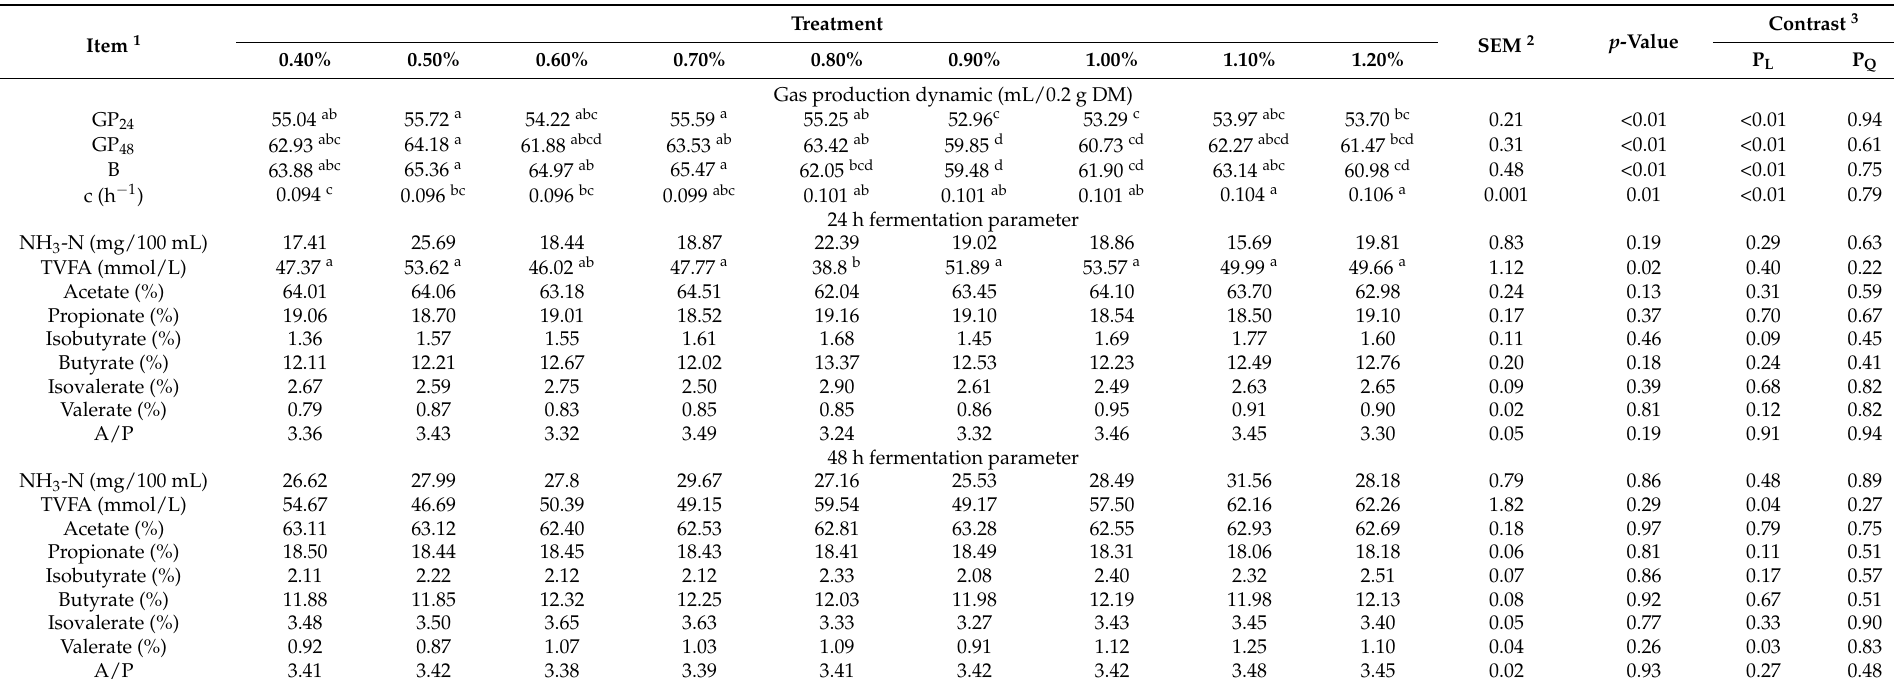
Table 3. The in vitro rumen fermentation of substrate with different levels of